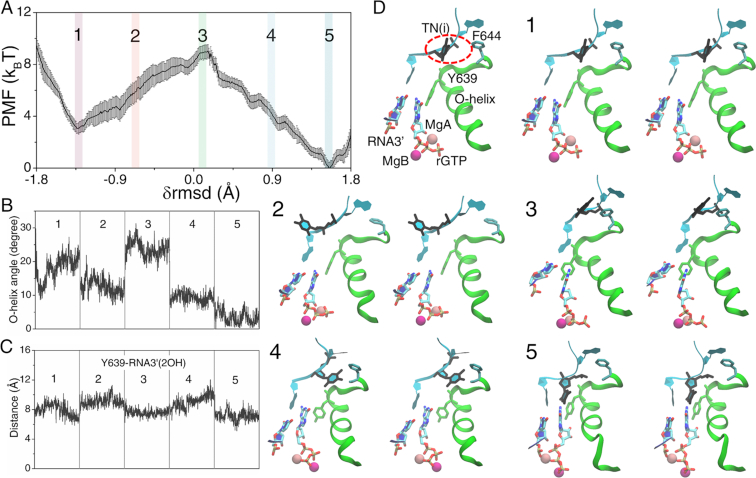
The PMF for the non-cognate rGTP bound RNAP complex from the pre-insertion off-path to the insertion state and key structure measures. (A) The PMF obtained from the umbrella sampling simulations along the collective reaction coordinate \documentclass[12pt]{minimal}
\usepackage{amsmath}
\usepackage{wasysym}
\usepackage{amsfonts}
\usepackage{amssymb}
\usepackage{amsbsy}
\usepackage{upgreek}
\usepackage{mathrsfs}
\setlength{\oddsidemargin}{-69pt}
\begin{document}
}{}${\rm{\delta rmsd}}$\end{document}. (B) The O-helix angle obtained from the five windows labeled on the PMF curve. (C) The distance between Y639 and RNA3′-2OH. (D) The five representative structures (in stereo views). A pre-insertion configuration (config 1) with TN(i), Y639, O-helix, MgA/B, rGTP, and RNA 3′ denoted is also shown. The red dashed circle highlights the significant base rotation of the template TN(i).